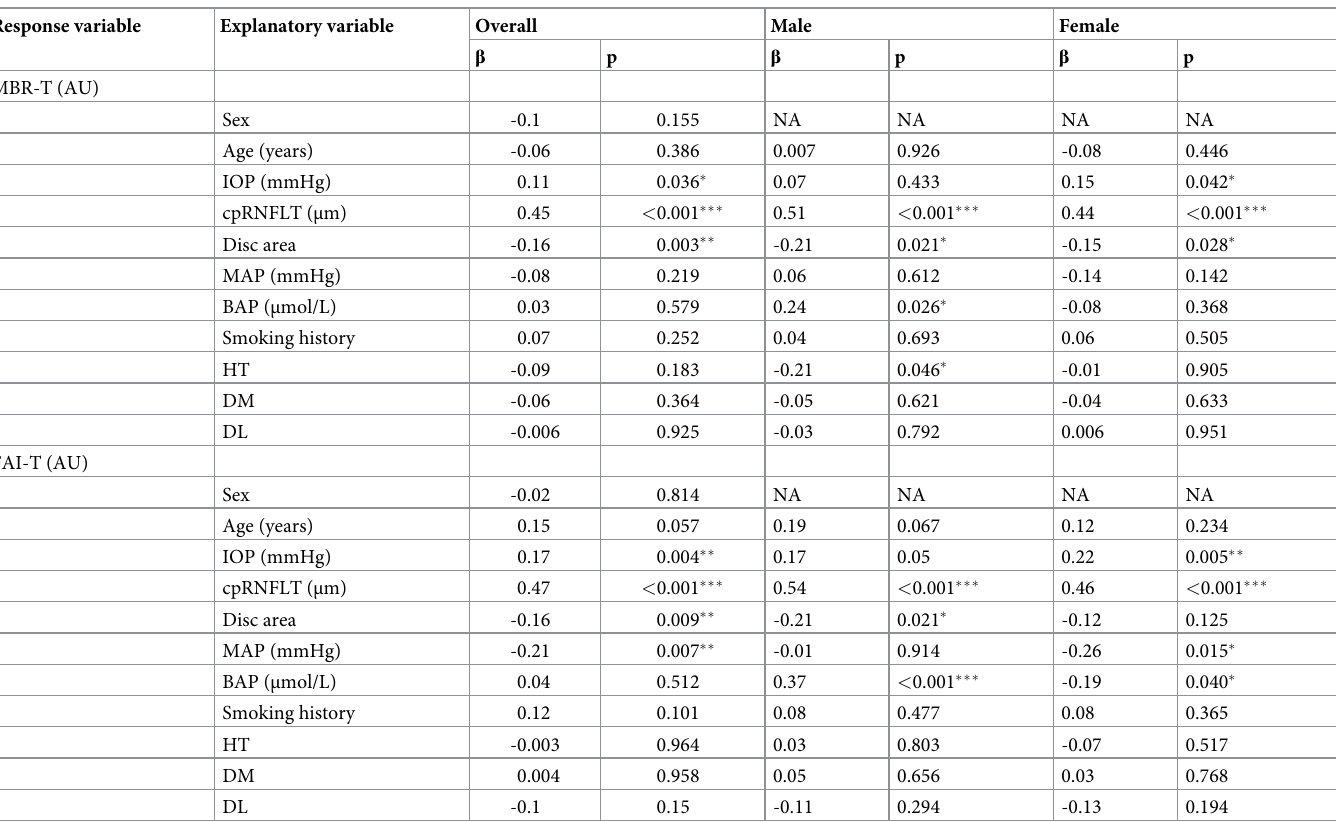
Table 4. The effect of clinical parameters on MBR-T and FAI analyzed with a linear mixed-effect model. Response variable